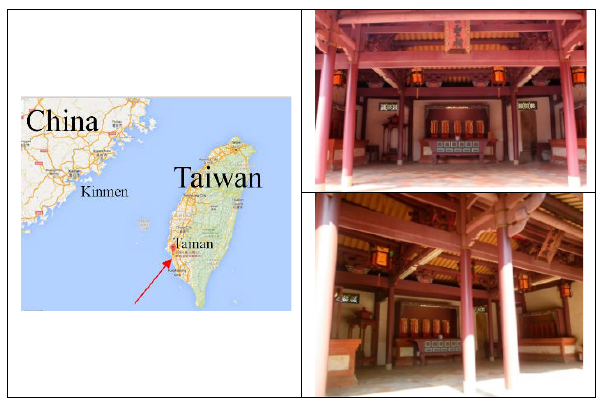
Fig. 1. Geological Location of Tainan Confucian Temple (the left, selected from Google Map), Photo (the right)